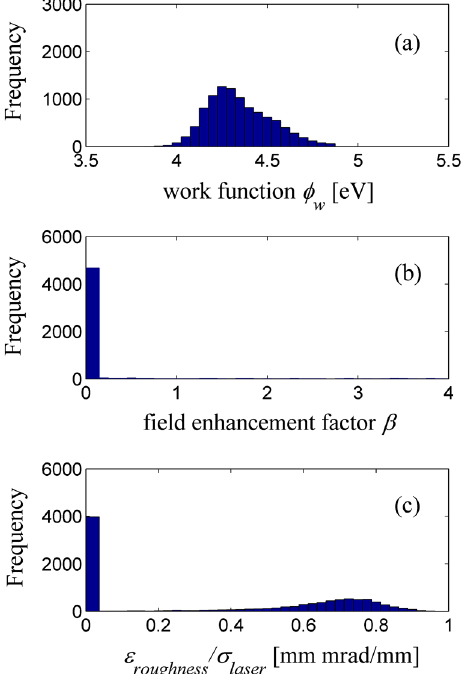
FIG. 1. 10 4 simulated fitting for model of Eq. (15) with 5% (rms) emittance data error: (a) histogram of work function fitting results, (b) histogram of field enhancement factor fitting results, and (c) histogram of roughness emittance fitting results at 50 MV = m